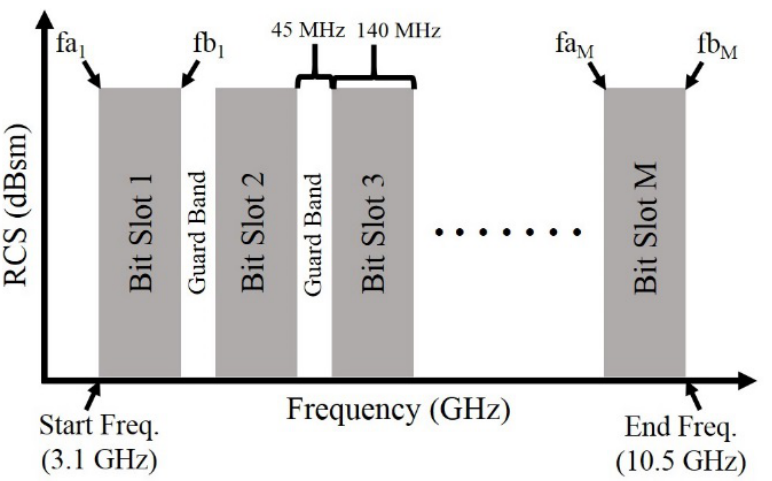
Figure 2. The spectral allocation for the proposed tag.